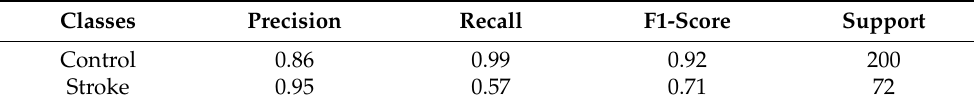
Table 4. K-nearest neighbor model classification report.